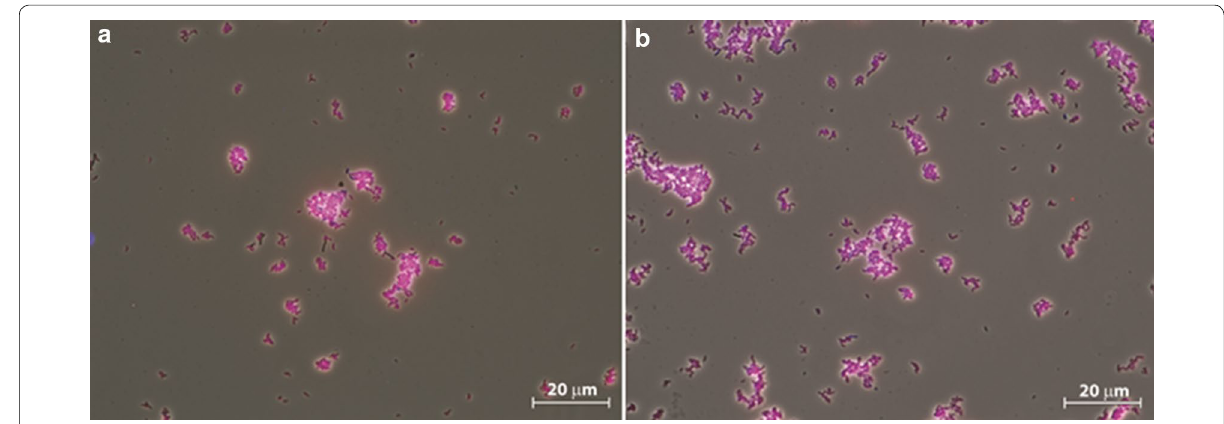
Fig. 2 FISH microscopic photographs of steady state cultures. a The culture grown on nitrate only. b The culture grown on nitrite only. The cells were stained with Cy5-labeled probes for bacteria (EUB338mix, blue), FLUOS-labeled probes for Betaproteobacteria (Beta42a, green) and Cy3-labeled probes specific for the reactor species (GeoBac464, red). Cells that are green indicate cells to which the probes EUB338mix and Beta42a were hybridized. Cells that are purple indicate cells to which the probes EUB338mix and GeoBac464 were